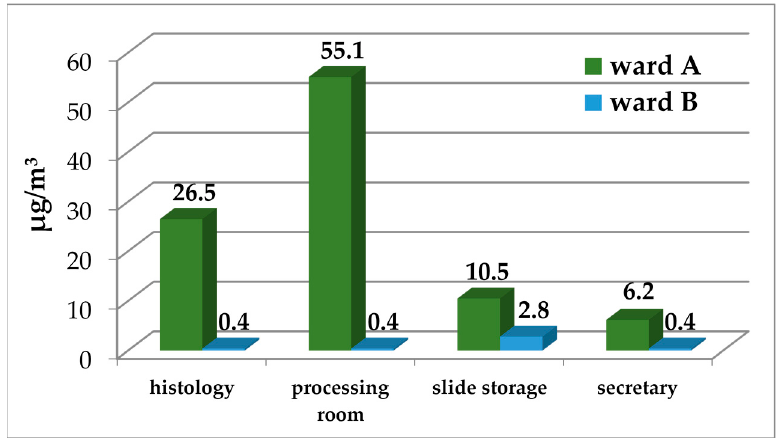
Figure 3. ∑ BTEX concentrations (µg/m 3 ) in the different places of two anatomical pathology wards (A,